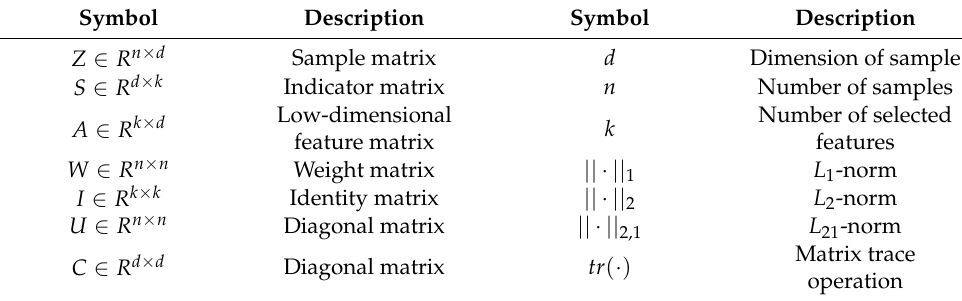
Table 1. Description of commonly used